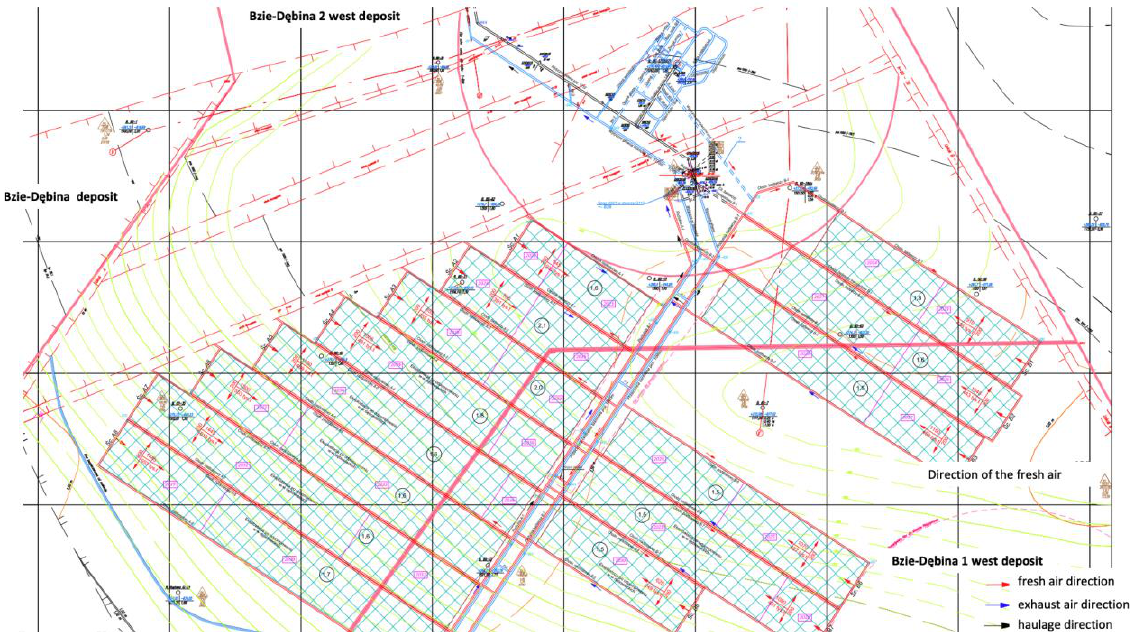
Figure 5. Map of the designed mining operations in the coal seam 404/1.